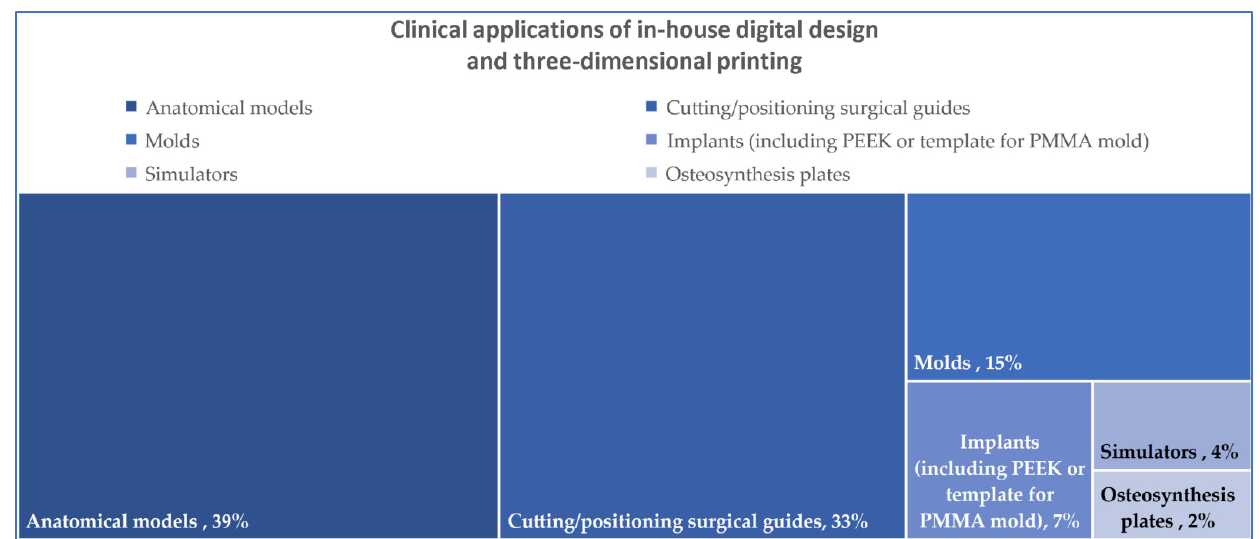
Figure 2. In-house 3DP of clinical applications across the studies and their percentual distribution.